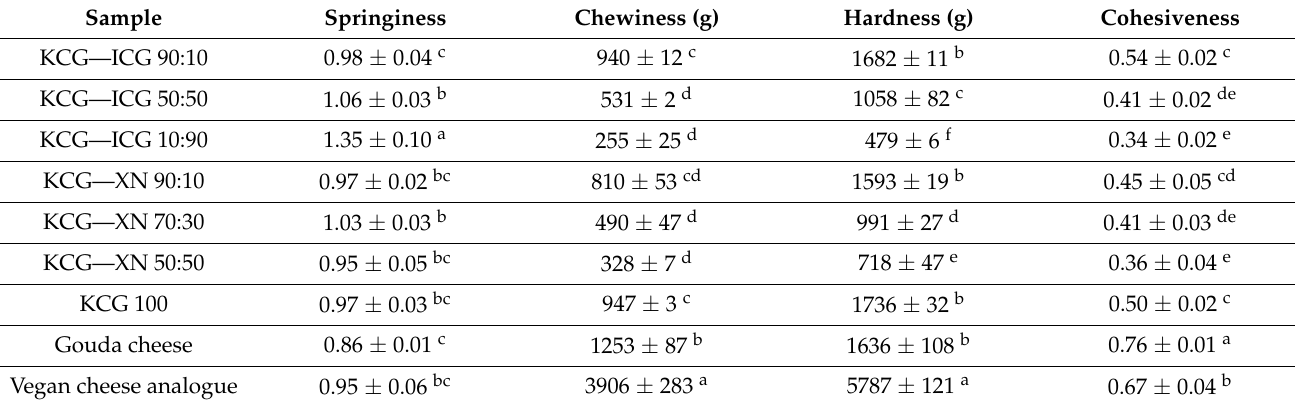
Table 3. The texture properties of cheese analogues made with different combinations of stabilizers 1